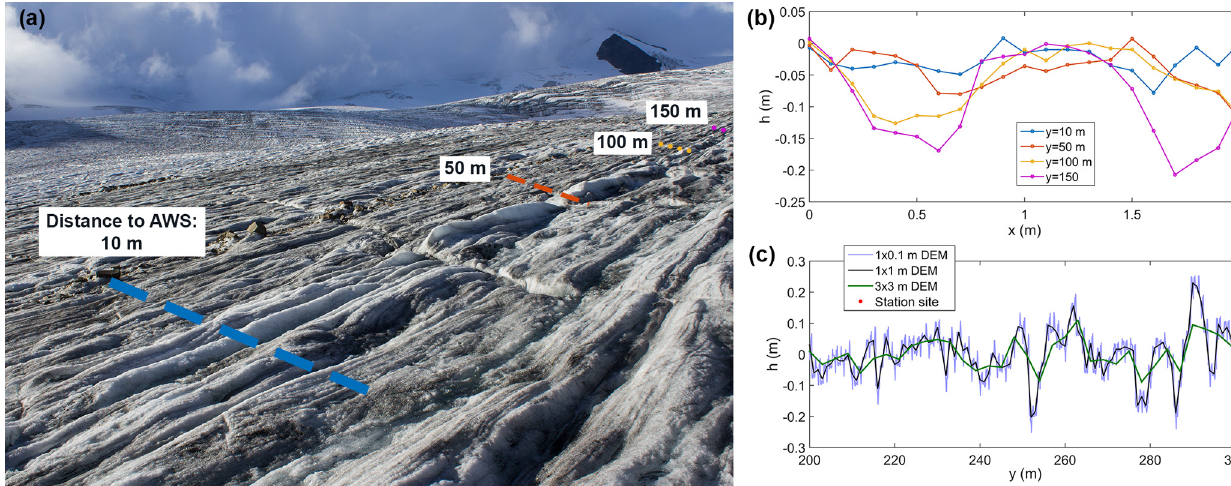
Figure 5. (a, b) Microtopography profiles taken upwind of CG16-1 at the end of the 2016 melt season. Profiles were 2m in width and taken perpendicular to the downslope direction. The locations of the profiles marked in panel (a) are representative rather than exact. (c) Examples of the filtered height profiles, as derived from the three DEM resolutions and used in the z 0v_prof sensitivity